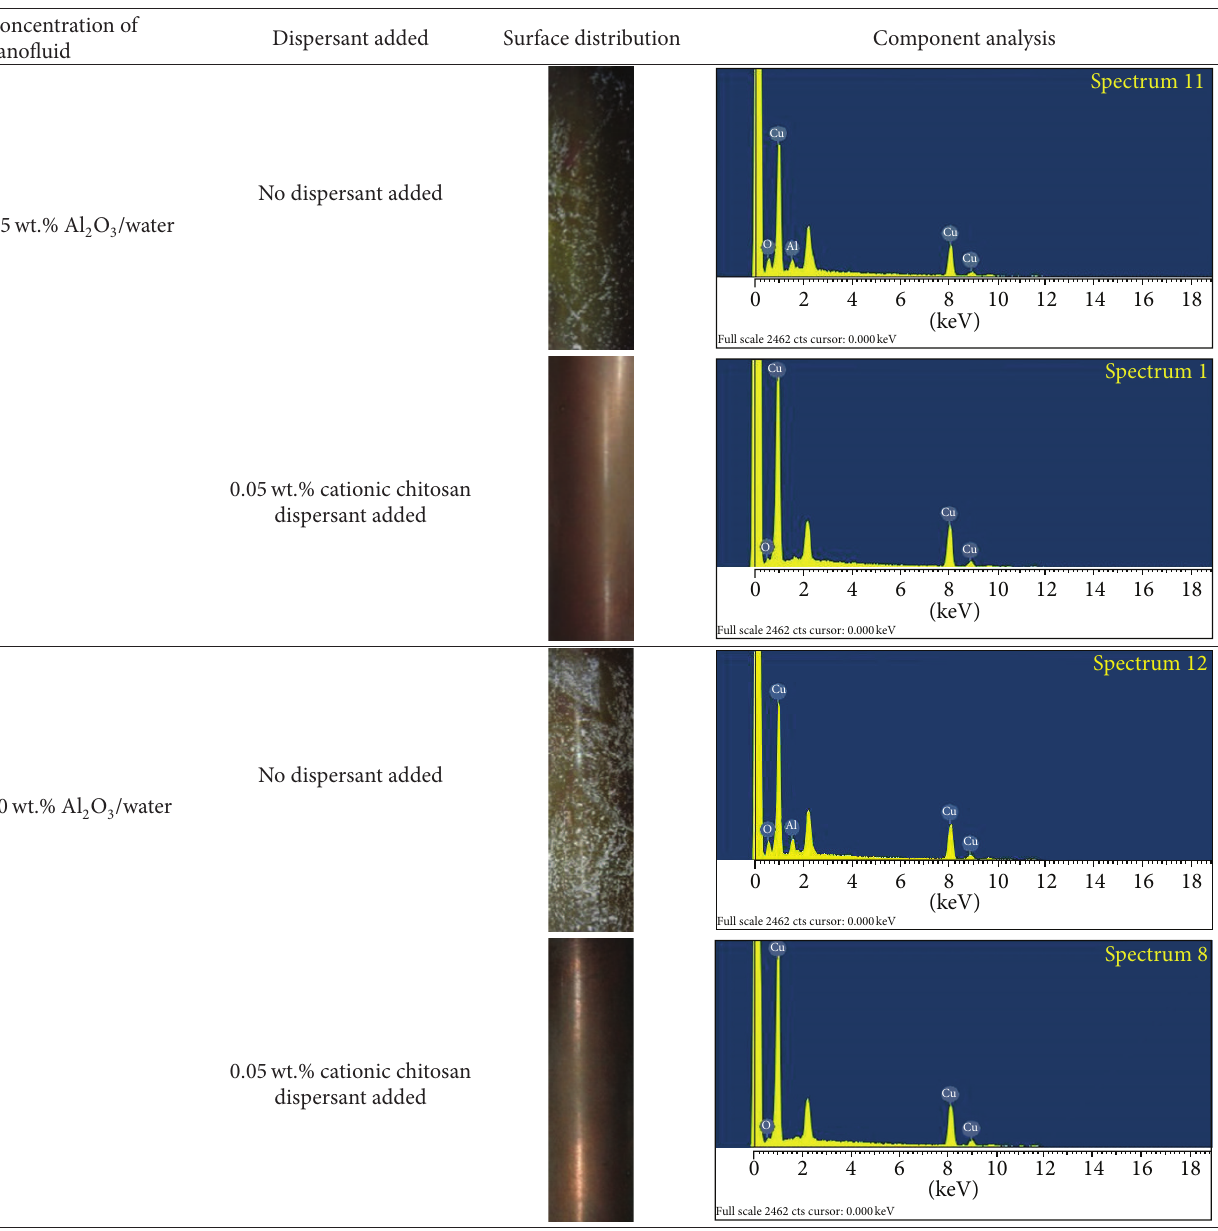
Table 2: Analysis of the component of copper surface in